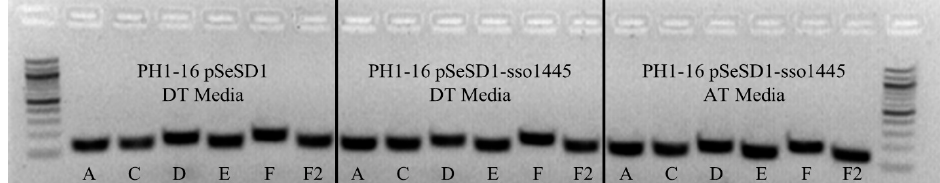
Figure 9. Overexpression of Csa3a in S. solfataricus does not lead to spacer acquisition. Leader proximal regions of the CRISPR loci were amplified from S. solfataricus PH1-16 cells carrying the empty pSeSD1 plasmid grown in DT media (uninduced, left ), cells carrying the pSeSD1-sso1445 Csa3a expression plasmid grown in either DT media (uninduced, middle ) or AT media (arabinose induced, right ). Acquisition of a new spacer would appear as a secondary band ~60 bp larger than the band amplified from WT cells. CRISPR loci are labeled below the bands. F2 is the second half of locus F, which is separated from the leader proximal region (Figure S1).